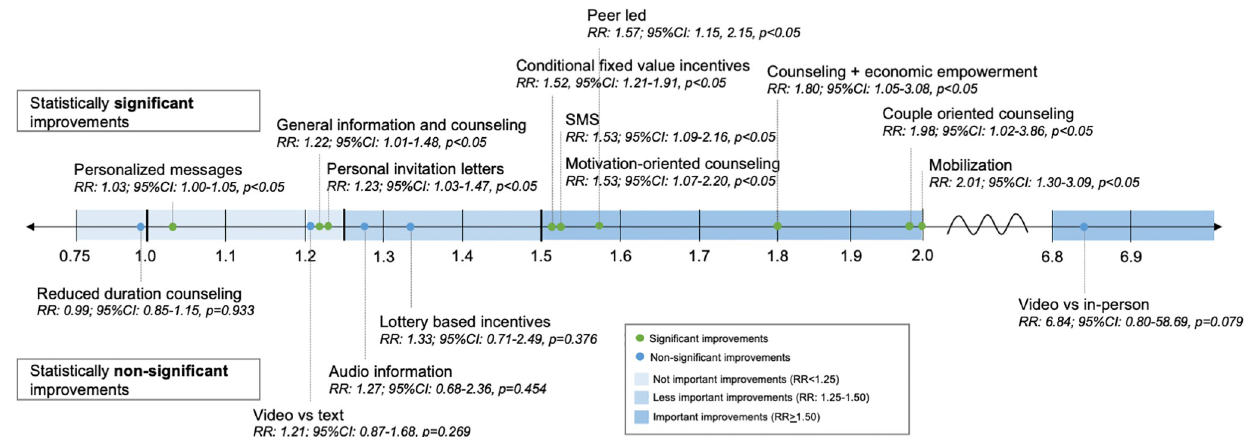
Fig 3. Summary of effect sizes of pooled estimates of uptake from meta-analysis. Pooled RR effect sizes ranged from near 1.0 (indicating no improvement in uptake of HTS) through nearly 7.0 (indicating a large effect size); not important improvements (RR < 1.25) are shown in light blue, less important improvements (RR: 1.25–1.50) are shown in medium blue, and important improvements (RR � 1.50) are shown in dark blue along the effect size spectrum from left to right. The statistical significance of each pooled estimate is indicated by green points (indicating statistical significance: p < 0.05) or blue points (indicating no statistical significance: p > 0.05). CI, confidence interval; HTS, HIV testing service; RR, relative risk; SMS, short message service; vs.,